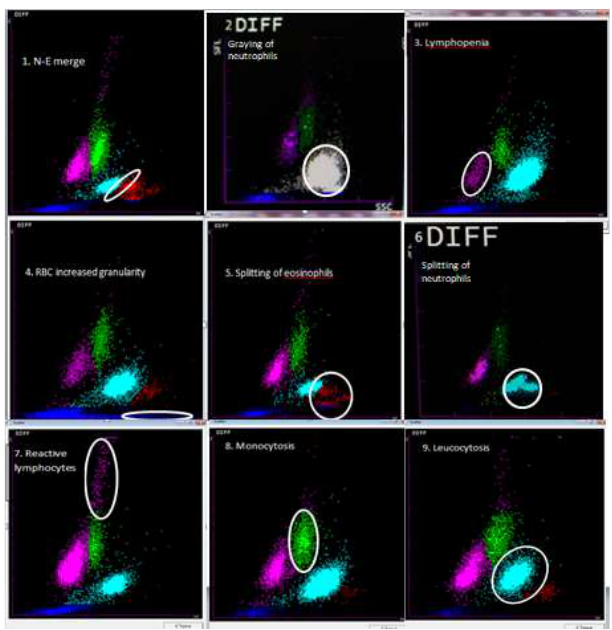
Figure 2 . Scatterplot variations and their interpretations:1. Neutrophil and eosinophil merge, 2. Graying of neutrophils, 3. Lymphopenia, 4. Increase in RBC granularity, 5. Splitting of eosinophils, 6. Splitting of neutrophils, 7. Reactive lymphocytosis, 8. Monocytosis, 9.